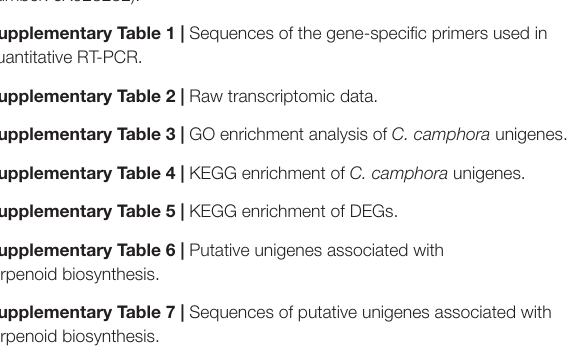
Supplementary Figure 1 | BUSCO analysis of the final transcriptomic assembly. Supplementary Figure 2 | Relationship between the samples. Supplementary Figure 3 | GO enrichment histogram of DEGs. Supplementary Figure 4 | Amino acid sequence alignment of identified LIS-like in C. camphora with linalool synthase CoLIS-LL in C. osmophloeum (accession number: JX028232). Supplementary Table 1 | Sequences of the gene-specific primers used in quantitative RT-PCR. Supplementary Table 2 | Raw transcriptomic data. Supplementary Table 3 | GO enrichment analysis of C. camphora unigenes. Supplementary Table 4 | KEGG enrichment of C. camphora unigenes. Supplementary Table 5 | KEGG enrichment of DEGs. Supplementary Table 6 | Putative unigenes associated with terpenoid biosynthesis. Supplementary Table 7 | Sequences of putative unigenes associated with terpenoid